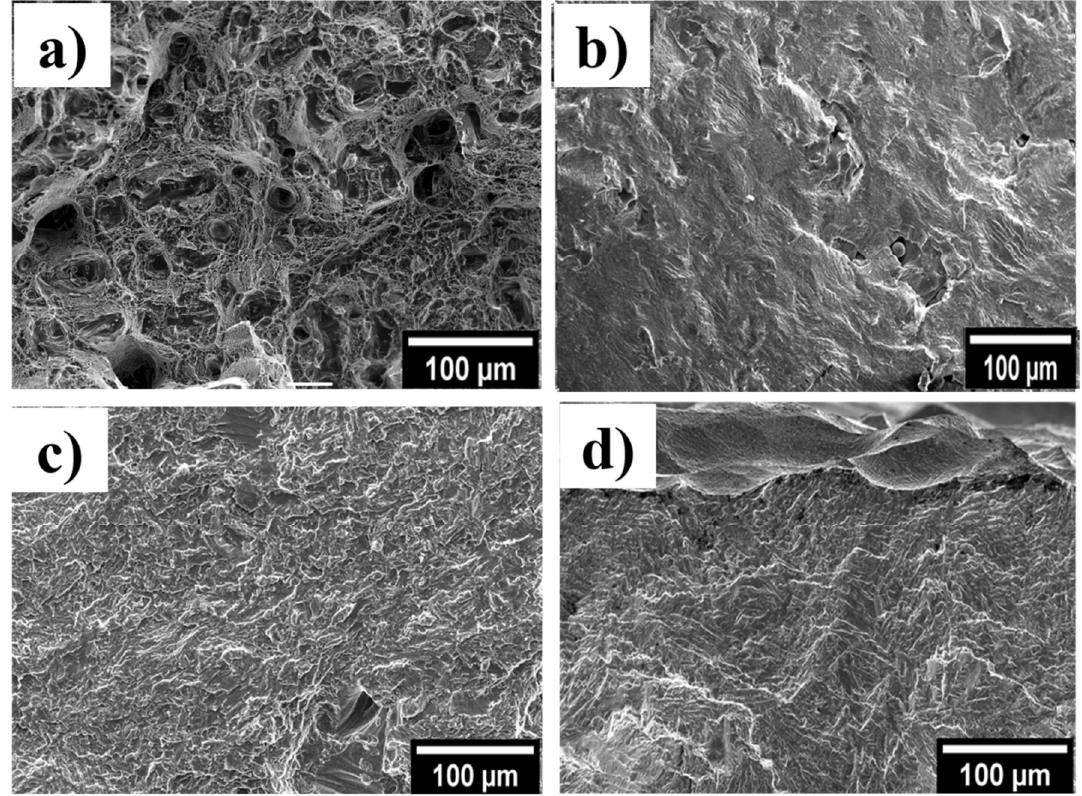
Figure 10. SEM images of fatigue fracture surfaces of ( a ) as‐fabricated printed Ti‐6Al‐4V, ( b ) HIP only, ( c ) HIP + PL and ( d ) HIP + CE.